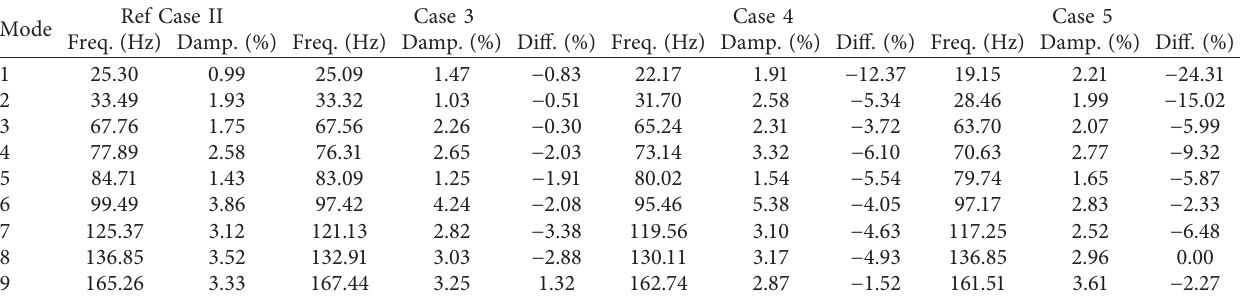
Table 2: Comparison of the identified modal information for Cases 3, 4, and